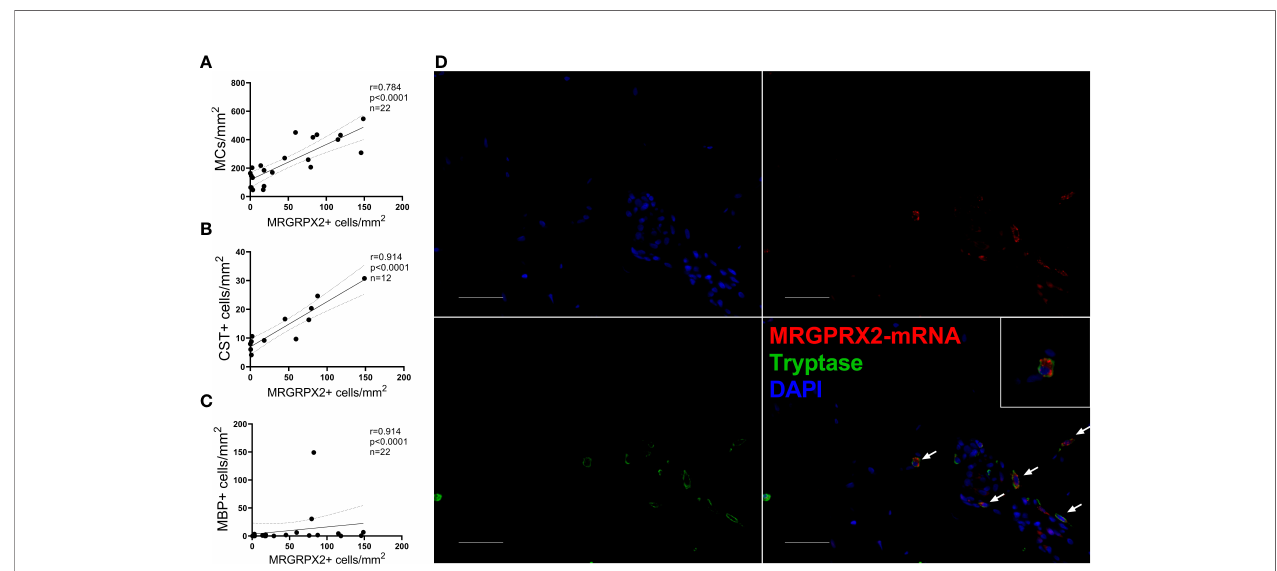
FIGURE 2 | Mast cells express MRGPRX2, and their numbers correlate with numbers of MRGPRX2+ cells in ISM patients. In lesional skin, the number of MRGPRX2+ cells correlates with the number of (A) MCs, (B) CST+, and (C) MBP+ cells. The Spearman correlation coef fi cient was applied to assess correlations. (D) Immuno fl uorescence staining of lesional skin of a patient with ISM #12 with anti-tryptase (green), anti-MRGPRX2 (red), and DAPI (blue). White arrows indicate some of tryptase-MRGPRX2 double- positive cells. ×400 magni fi cation. Bar = 50 µm. CST, cortistatin; DAPI, 49-6-diamidino-2-phenylindole dihydrochloride; MBP, major basic protein; MC, mast